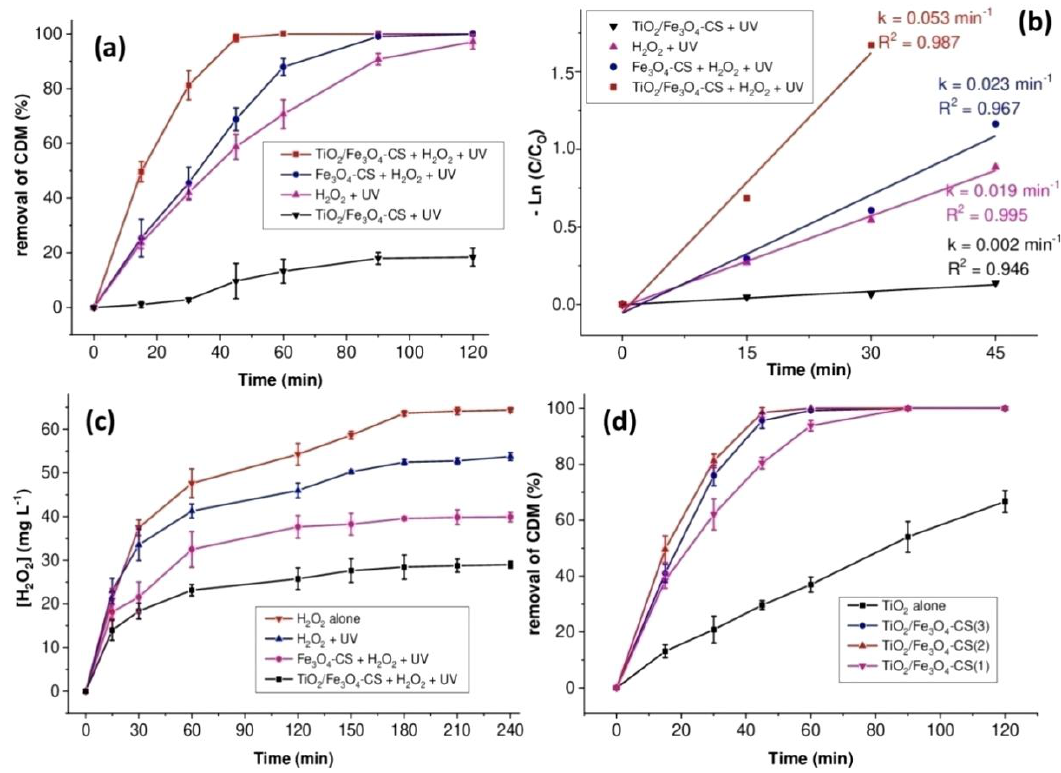
Figure 1. Performance comparison of several processes and effect of the addition of TiO 2 to magnetic chitosan beads: ( a , d ) % removal of CDM; ( b ) − Ln (C/C0) vs. time; ( c ) [H 2 O 2 ] vs. time: I = 50 mA in the presence of 1 g L −1 of catalyst and at pH i = 3. Table 2. The comparison of photodegradation efficiency of TiO 2 /Fe 3 O 4 -CS catalytic beads with other TiO 2 /Fe 3 O 4- based materials against different pesticides.